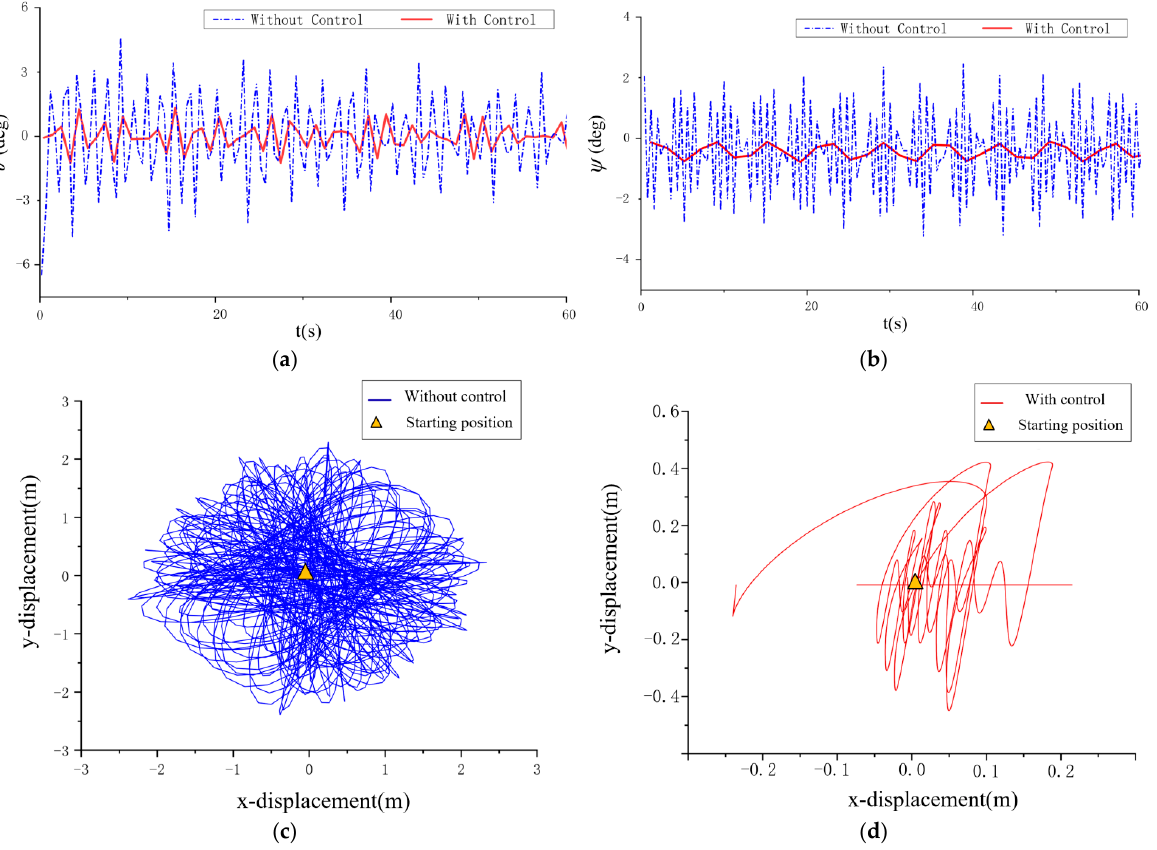
Figure 10. The dynamic response of TTAS under the irregular waves. ( a ) The in-plane angle ( θ ) of the payload in the irregular waves; ( b ) in the irregular waves, the out-of-plane angle ( Ψ ) of the payload; ( c ) the x, y displacement of the payload without control; ( d ) the x, y displacement of the payload with control.